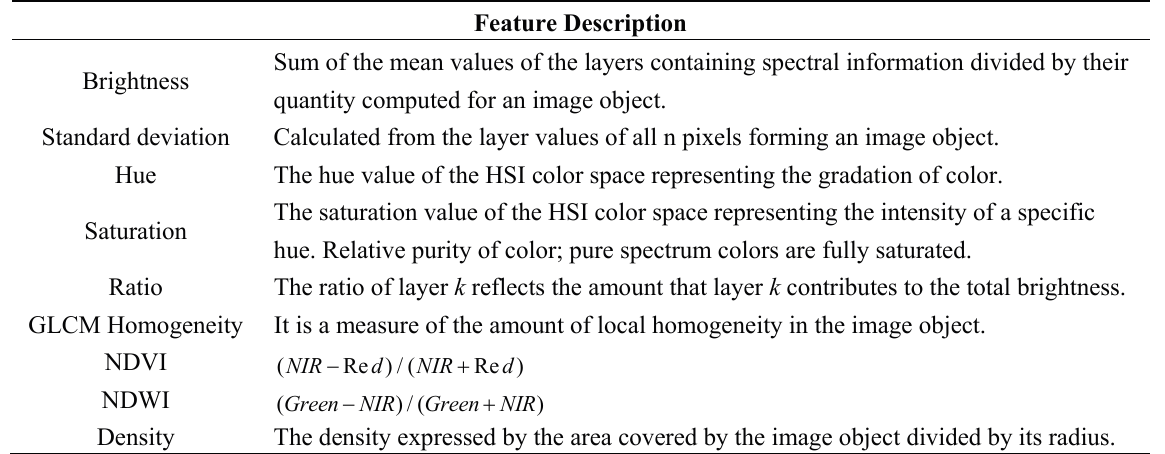
Table 3. Optimum Feature